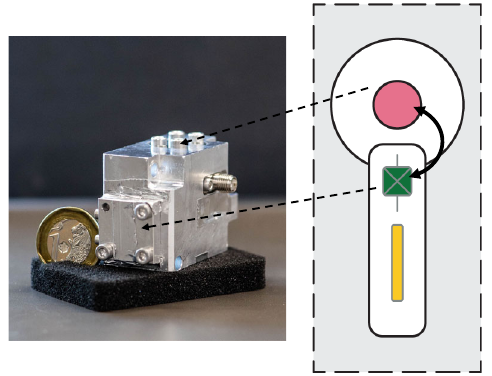
FIG. 5. cQED hardware. Photograph of a device machined out of high-purity aluminum consisting of one storage cavity (pink), single junction transmon (green), and planar readout resonator (gold).